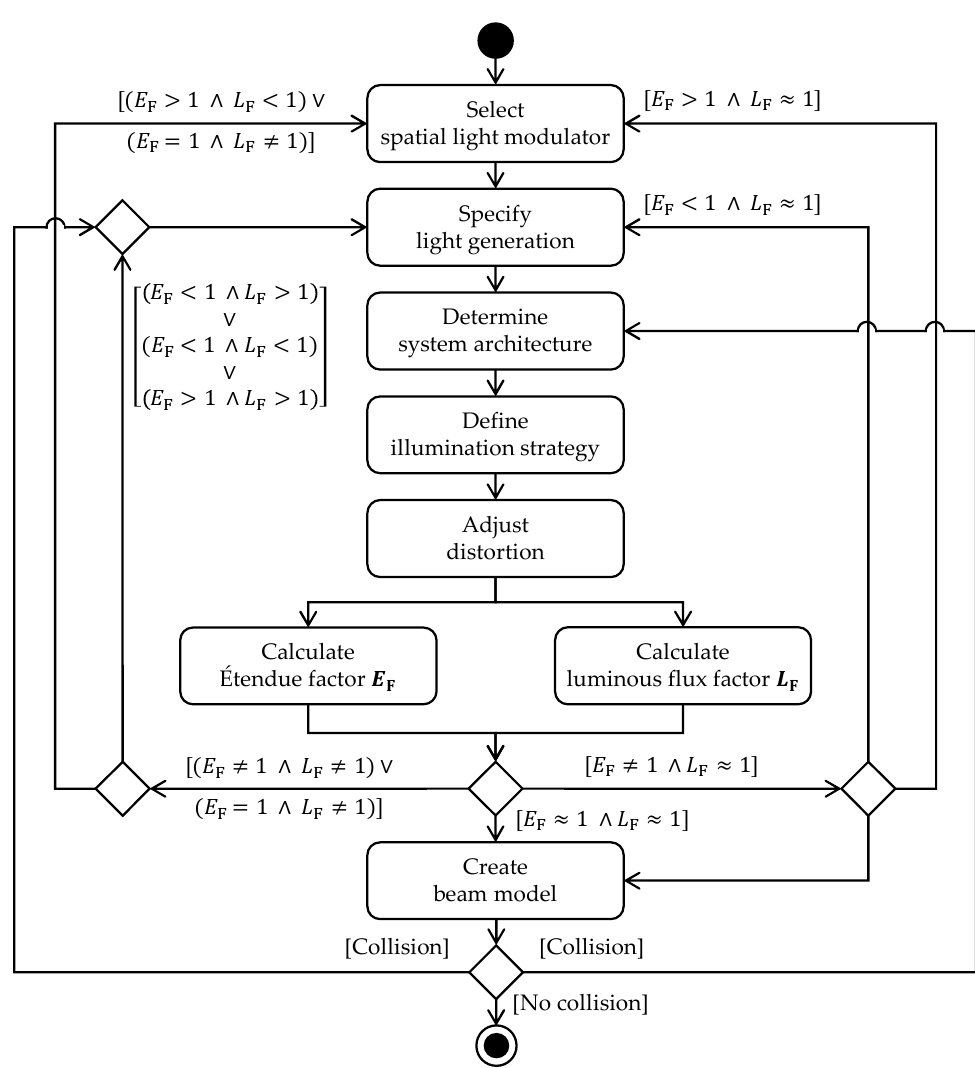
Figure 7. Method for the preliminary design of high-resolution lighting systems according to